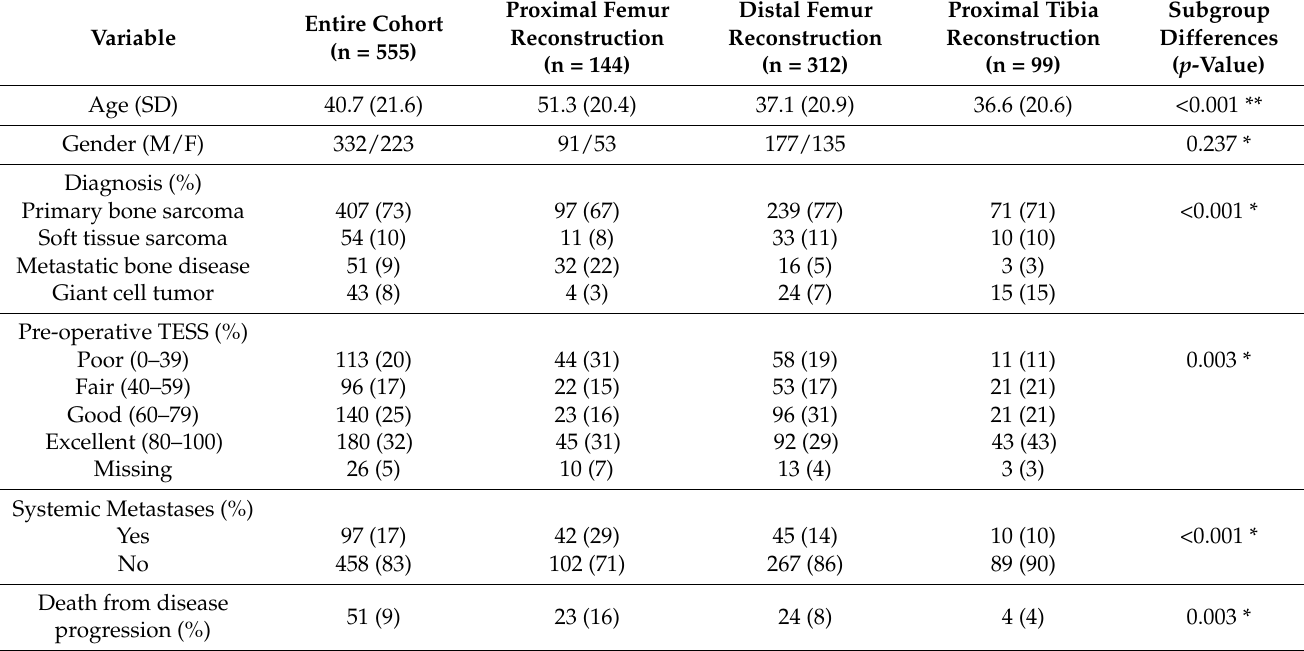
Table 1. Patient characteristics.